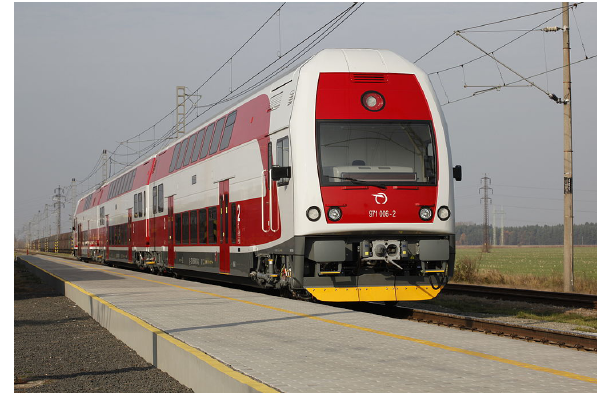
Figure 1: Electric double-decker multiple-unit series 671 (Source: Skoda